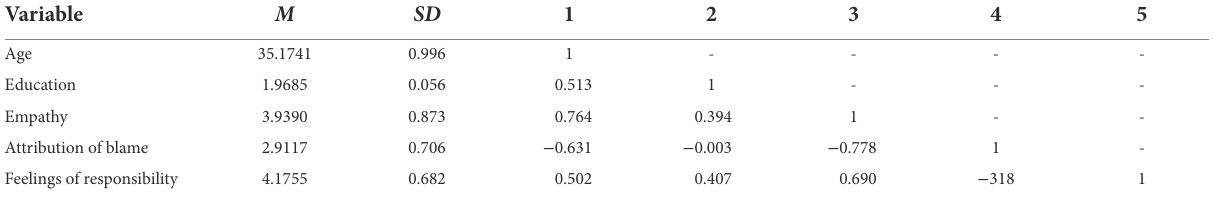
TABLE 4 Correlation co-efficiencies between